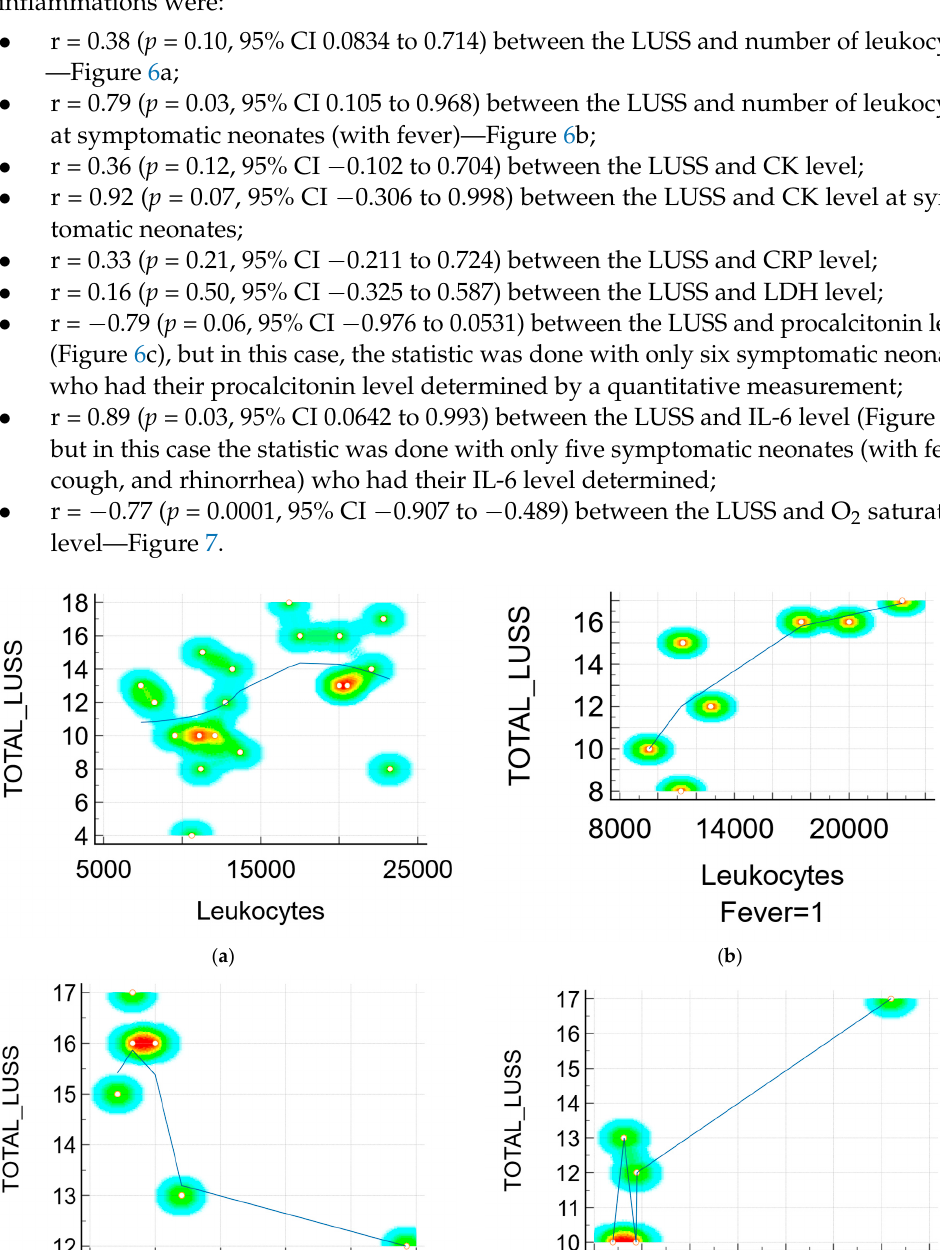
Figure 6. Scatter diagram with heat map of correlation between LUSS and biomarkers: ( a ) LUSS and number of leukocytes from all neonates; ( b ) LUSS and number of leukocytes from the neonates with symptoms—a positive linear correlation; ( c ) LUSS and procalcitonin level—a negative linear correlation; ( d ) LUSS and IL-6 level—a positive linear correlation.